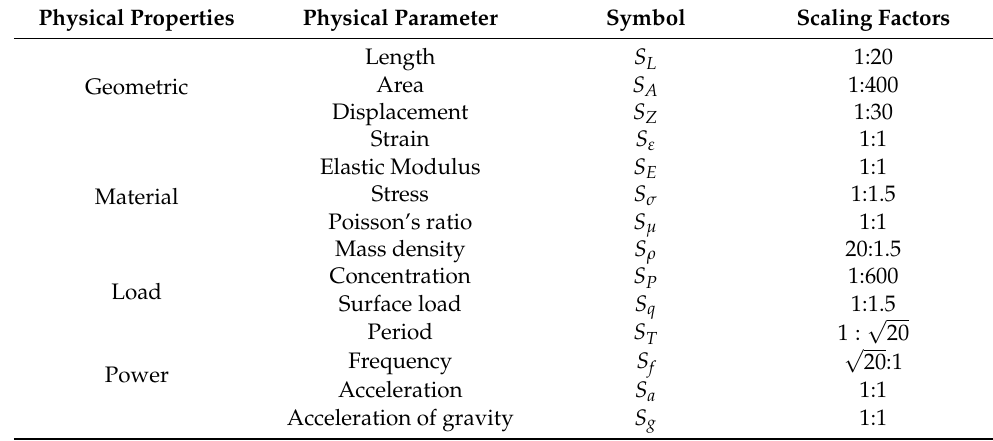
Table 3. The similarity constants of the main physical parameters of the scale model.